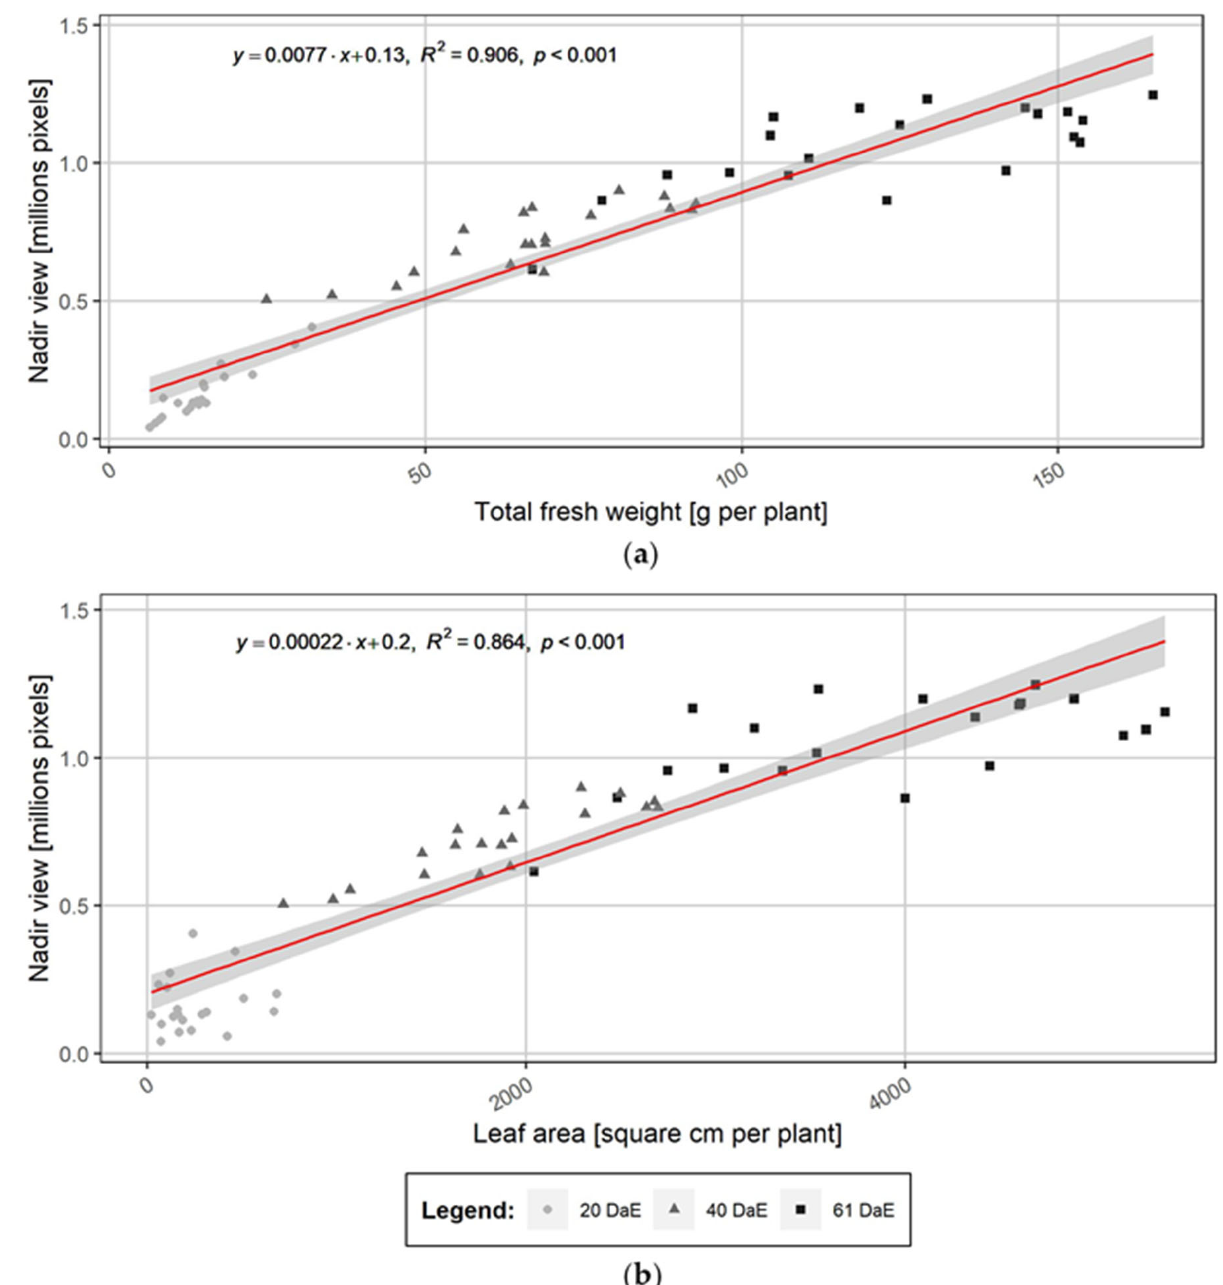
Figure 4. Linear regressions: ( a ) between the projected leaf surface measured from the nadir view (in millions of pixels) and total shoot fresh weight (g plant − 1 ); and ( b ) between the projected leaf surface measured from the nadir view (in millions of pixels) and total leaf surface (cm 2 per plant) of water yam (cv raja ala) grown in a greenhouse in the presence of different N fertilization rates. The linear regressions, the coefficients of determination ( R 2 ) and the p values are shown on each graph. The form of the symbols indicates the sampling dates: 20, 40 and 61 days after emergence (DaE) ( n = 60 plants for both figures). The grey band indicates the 95% confidence interval.